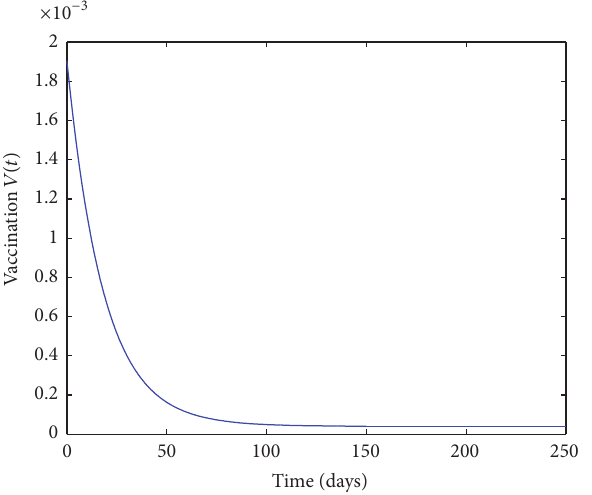
Figure19:Cullingeffort 𝜌 𝐷 𝐷(𝑡) whenadailycullingrateof 𝜌 𝐷 = 0.1 and vaccination law 𝑉 = 0.2𝑏 1 + 0.002𝑆(𝑡) are applied.